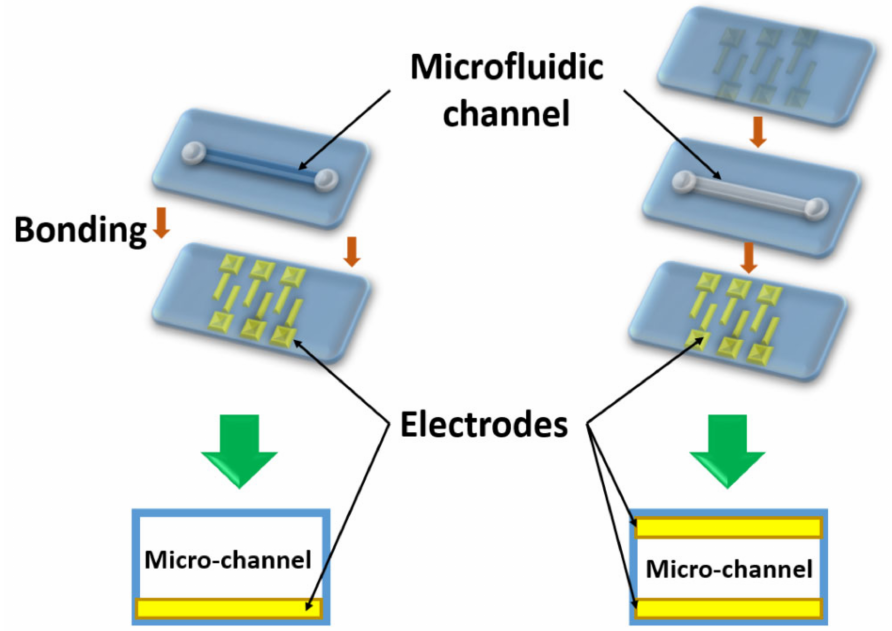
Figure 14. Schematic view on the possible electrodes location in a microfluidic chip. The left–microfluidic channel is structured in the layer, the right–channel is cut through the layer and one more slide with electrodes on top. The black arrows point the location of the microfluidic channel and electrodes, red arrows are leading through the technological process and green arrows point the resulting structures.